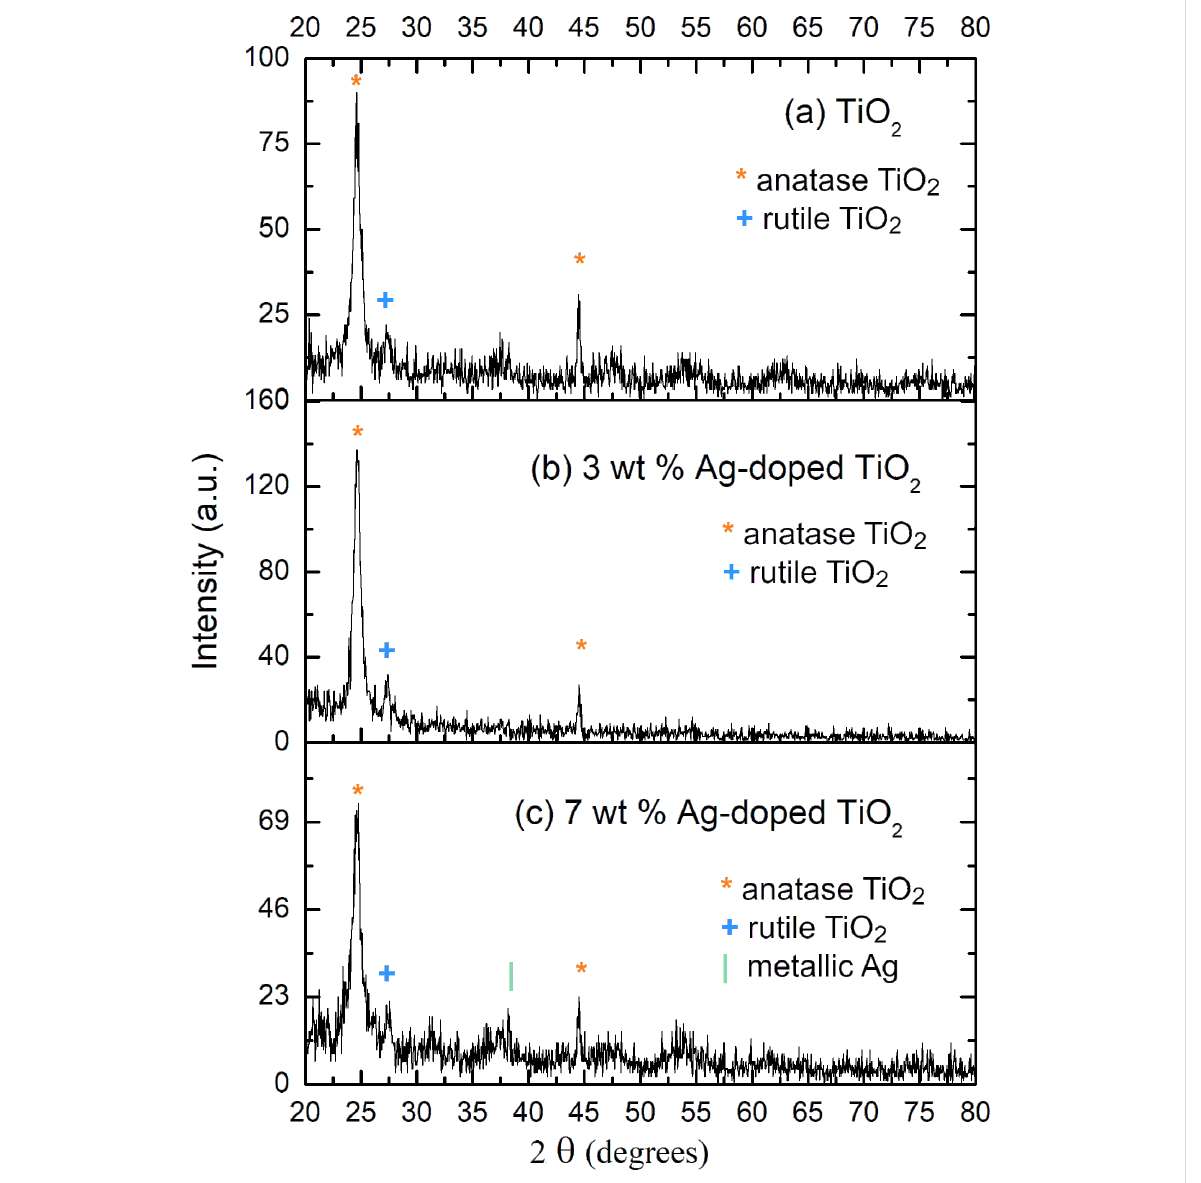
Figure 1: XRD patterns of (a) TiO 2 nanoparticles, (b) 3 wt % Ag-doped TiO 2 nanoparticles and (c) 7 wt % Ag-doped TiO 2 nanoparticles annealed at 450 °C. Supporting Information File 1 contains the raw data files used to create this figure.